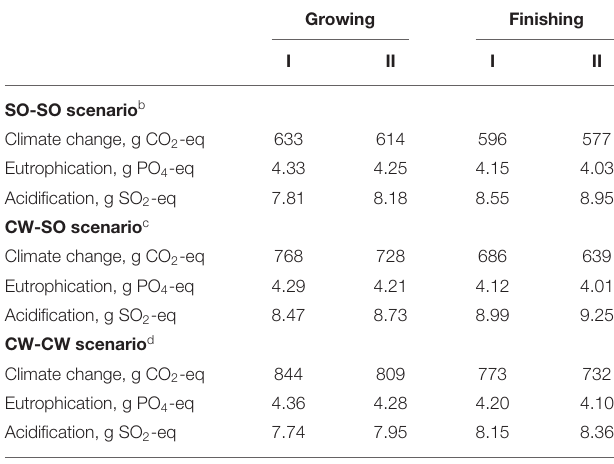
TABLE 5 | Potential environmental impacts of control feeds a (1kg at feed mill gate, formulated without β -mannanase) for nursery piglets in different grain production scenarios.